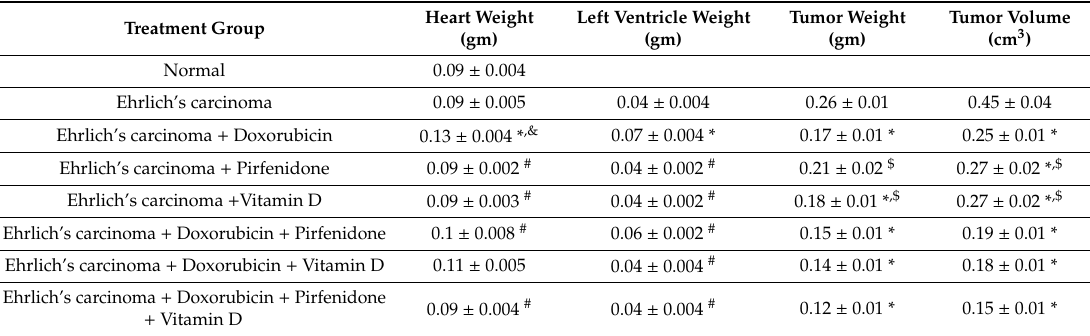
Table 1. E ff ect of doxorubicin (15 mg / kg; i.p.) and / or pirfenidone (500 mg / kg; p.o.), vitamin D (0.5 µ g / kg: i.p.) on heart, left ventricle, tumor weight, and tumor volume for all groups two weeks starting from day 8 after EAC implantation. * p < 0.05 with respect to control EAC, & p < 0.05 with respect to normal, # p < 0.05 with respect to doxorubicin. $ p < 0.05 with respect to the co-therapy of